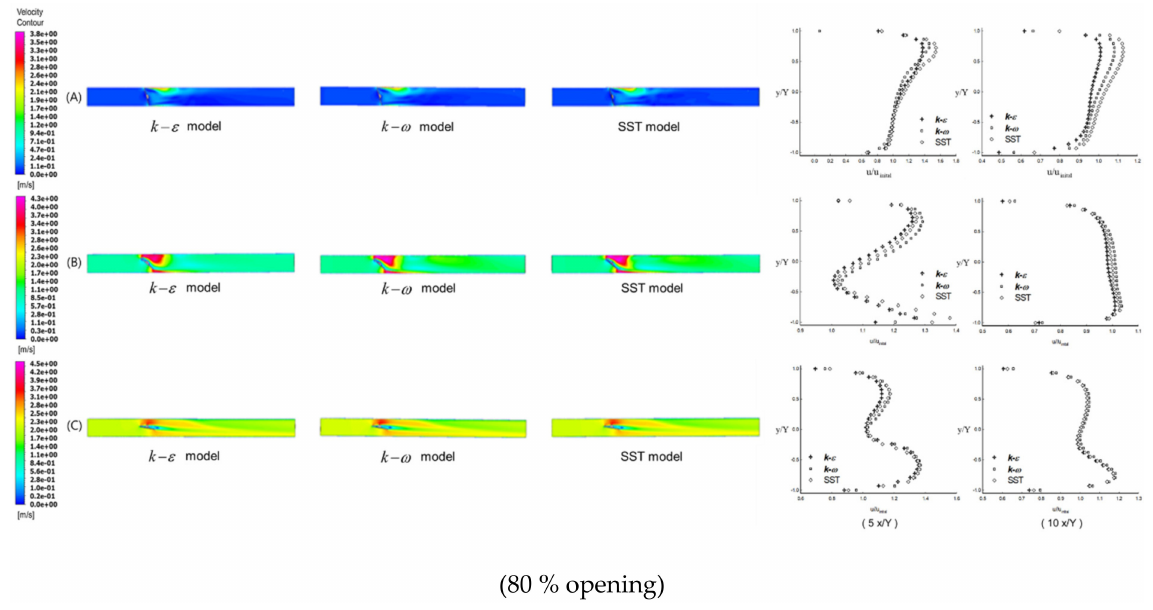
Figure 4. Velocity contour and profile with different opening for the k − ε , k − ω , and SST turbulence models: ( A ) DN 80, ( B ) DN 262, ( C ) DN 400.